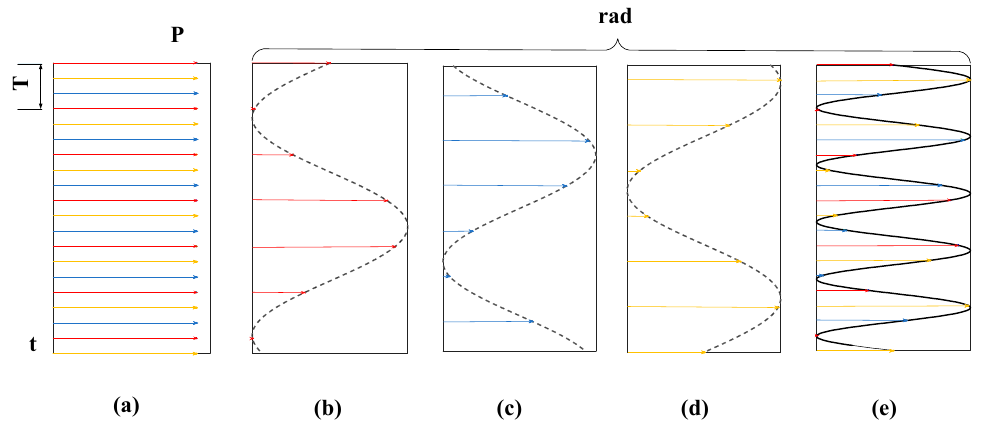
Figure 13. Schematic diagram of the Synthesis Algorithm. ( a ) The time-power curve of the pulses; ( b ) The vibration signals demodulated from the pulse with ∆ f 1 ; ( c ) The vibration signals demodulated from the pulse with ∆ f 2 ; ( d ) The vibration signals demodulated from the pulse with ∆ f 3 ; ( e ) The vibration signal after interleaving algorithm.